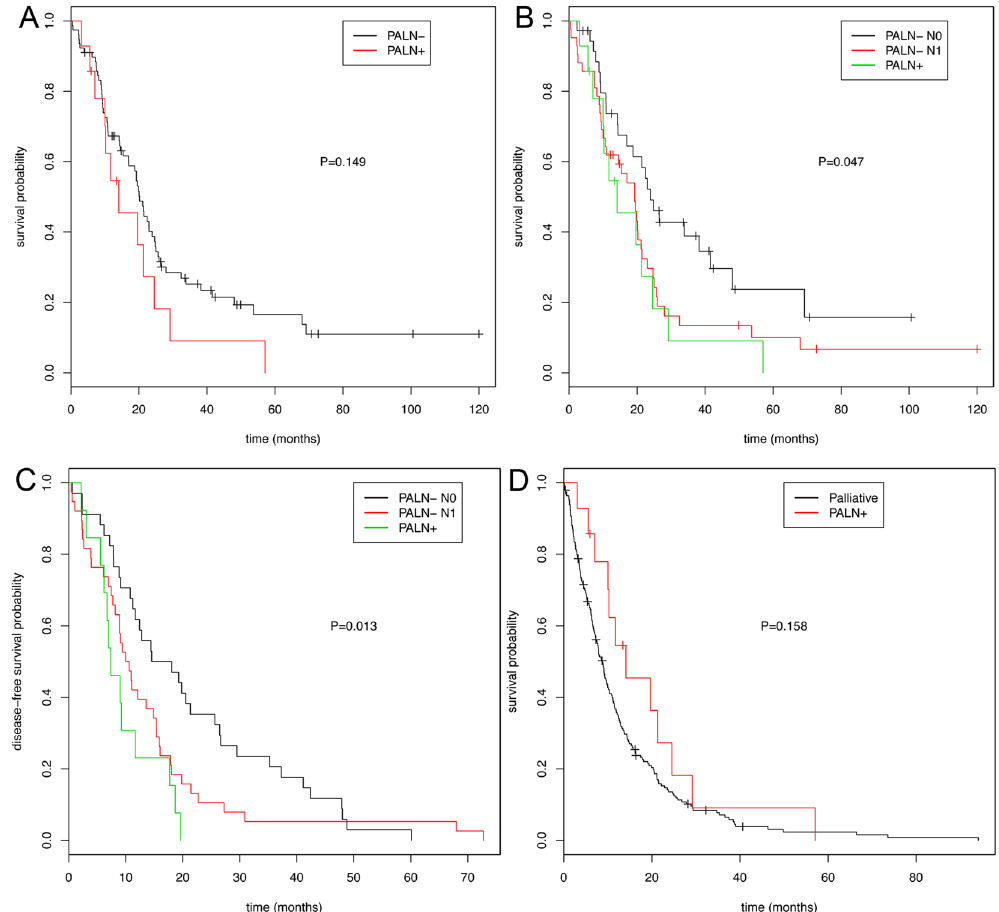
Figure 1. Overall and disease-free survival of patients with para-aortic lymph node resection. ( A ) Overall survival of patients with para-aortic lymph node (PALN) resection (n = 95). Patient subgroups with PALN metastasis (PALN + , n = 14) and without PALN metastasis (PALN − , n = 81) were plotted. ( B , C ) Overall survival ( B ) and disease-free survival ( C ) of patients with PALN resection separated into PALN + (n = 14), PALN − pN0 (n = 37), and PALN − pN1 (n = 44) subgroups according to the regional lymph node status. ( D ) Overall survival of PALN + patients (n = 14) compared with patients after palliative surgery for unresectable or metastastic pancreatic cancer (n =